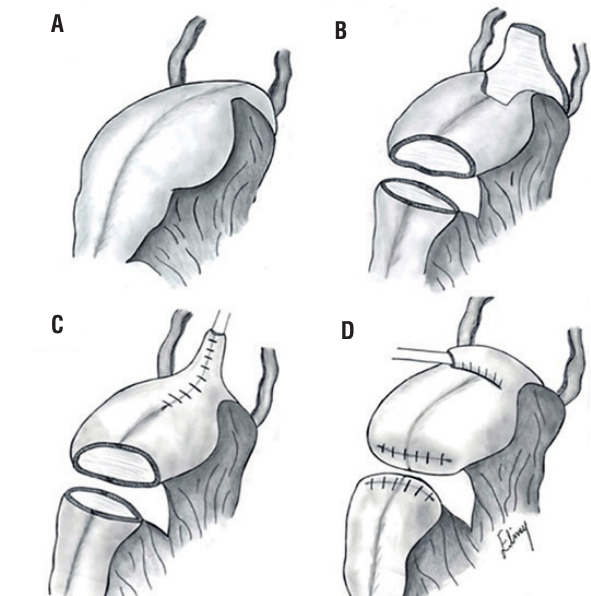
figure 3 - A) previous neobladder and ureteres. B) Neobladder division and flap made from the anterior surface of it. c) creation of the efferent conduit with placed of a urinary catheter. D) creation of the antireflux valve and closure of distal end of continente cutaneous reservoir. Moreover proximal end of future neovagina it was closed